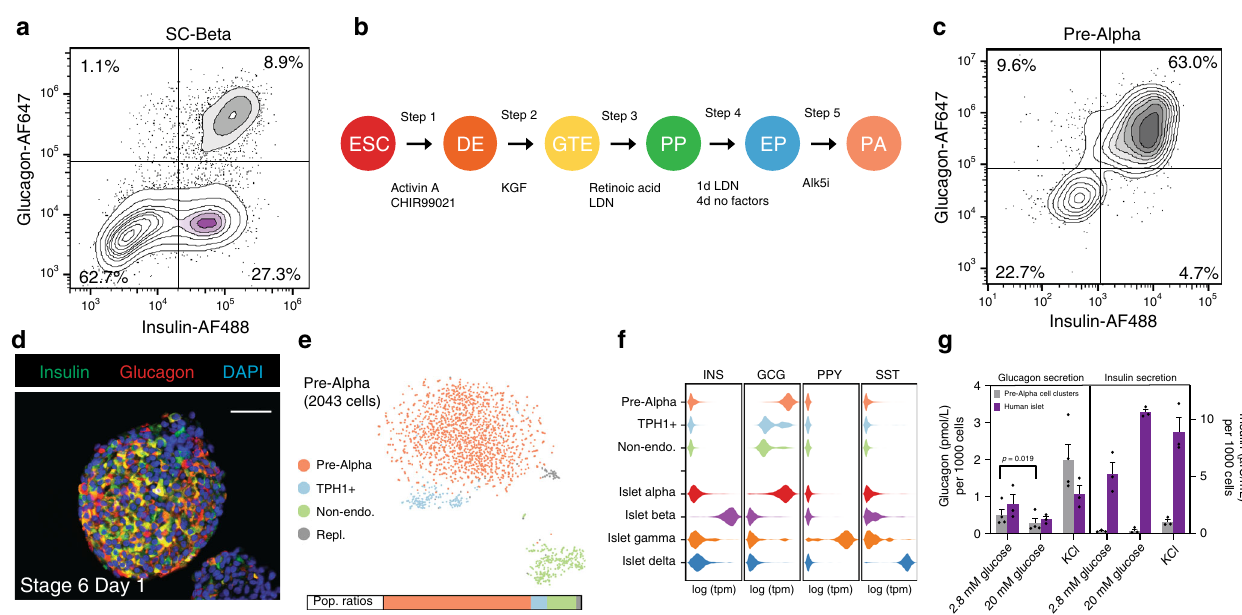
Fig. 1 The development of protocols for generating pre-alpha cells. a Embryonic stem cell differentiation to SC-beta cells results in a heterogeneous population. In this differentiation, 8.9% of cells coexpress markers for insulin and glucagon. b Schematic of directed differentiation protocol from hPSC into pre-alpha cells. The factors added at each step are noted below, catalog numbers are provided in Supplementary Table 1. c In the resulting pre-alpha cell differentiation, 63% of the cells stain for glucagon and insulin proteins. d Immuno fl uorescent cross-sectional staining of a cluster for insulin and glucagon. Scale bar = 50 μ m. e Single-cell RNAseq analysis of pre-alpha cells from the SC-alpha protocol. Expression data are visualized with a tSNE plot where cells are clustered based on the similarity of transcript expression patterns. The expression pro fi le for cells in the pre-alpha cell cluster is similar to the expression pro fi le of human islet alpha cells (Supplementary Fig. 17b). Population ratios by this analysis are consistent with the fl ow cytometry plot in c . f Histograms of expression levels (as violin plots) for pancreatic hormones of SC-alpha cells and cadaveric human islets 27 . g Pre-alpha cells secrete glucagon, but do not secret insulin. Representative ELISA measurements of secreted glucagon (left panel) from HUES8 differentiated pre-alpha cells or human islets challenged sequentially with 2.8 or 20 mM glucose with a 60-min incubation for each concentration. Representative ELISA measurement of secreted full processed human insulin (right panel) from HUES8 differentiated pre-alpha cells or human islets challenged sequentially with 2.8 or 20 mM glucose with a 60-min incubation for each concentration. Data presented as mean glucagon or insulin secreted per 1000 total cells ± SEM ( n = 3 biologically independent samples) Signi fi cance calculated using a two-tailed paired Student ’ s t test. ESC: embryonic stem cell, DE: de fi nitive endoderm, GTE: gut tube endoderm, PP: pancreatic progenitor, EP: endocrine progenitor, PA: pre-alpha cell, KGF: keratinocyte growth factor, LDN: LDN193189, Alk5i: Alk5 inhibitor II, Repl.: replicating